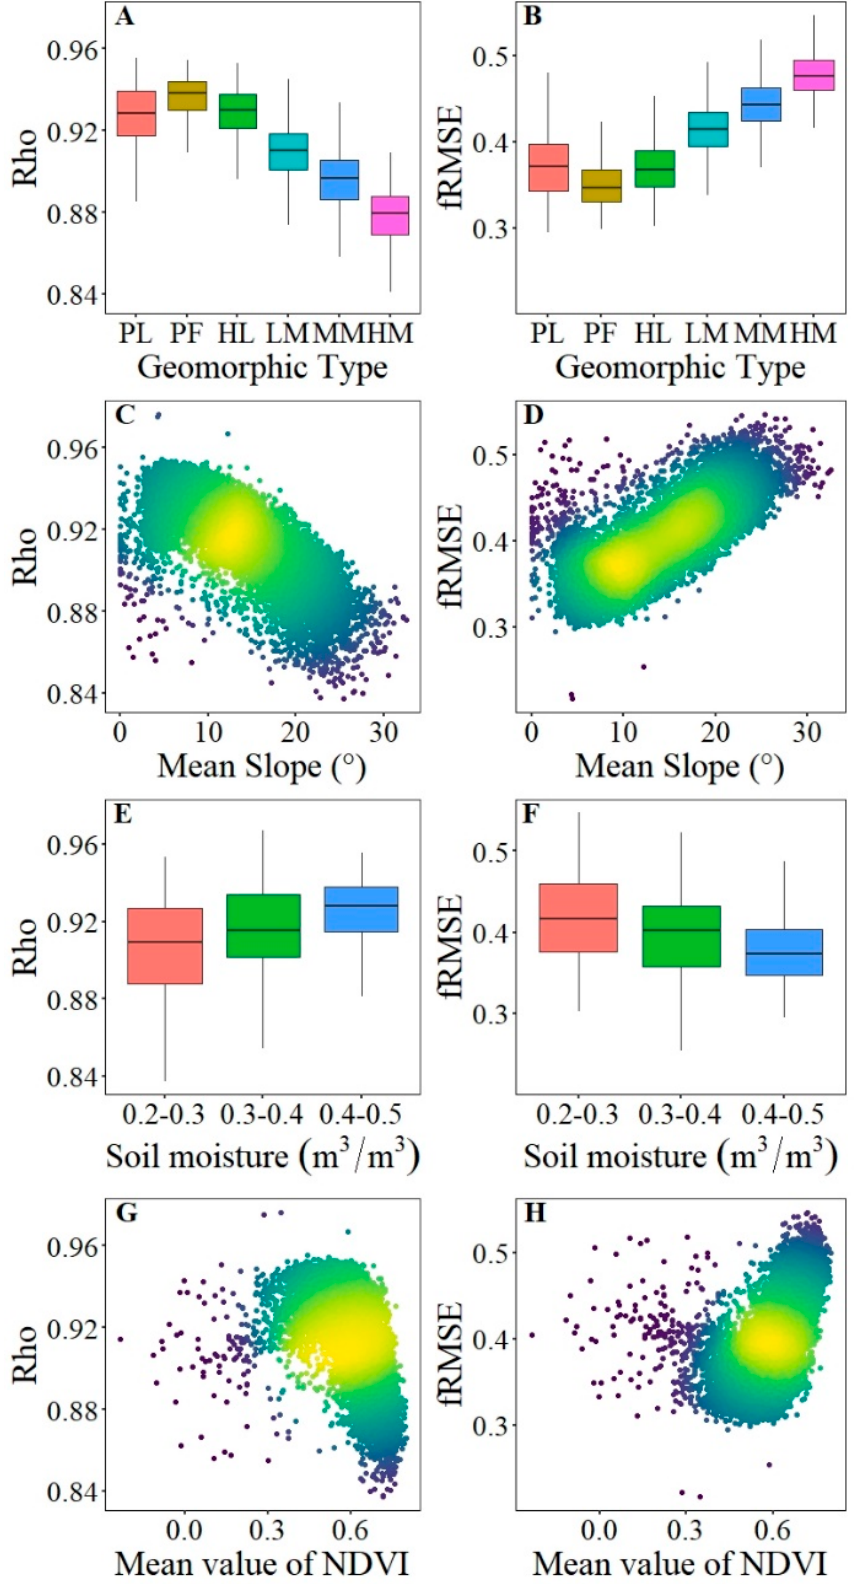
Figure 8. Effect of landform, slope, soil moisture and NDVI on the accuracy of FY-4A LST data; abbreviations for landform are: PL Plain, PF Platform, HL Hill, LM Low relief mountain, MM Medium relief mountain, HM High relief mountain.